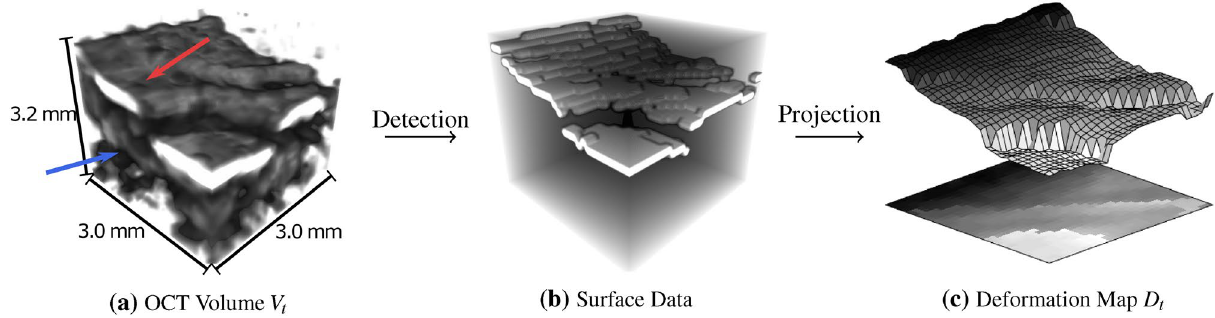
Figure 2. Data Representation: Visualization of the two data representations considered during our learning tasks. (a) The volumetric OCT scan V t contains the surface data (red arrow) and the depth information (blue arrow). (b) We detect the sample surface data in the OCT volume. (c) We project the surface data onto our 2D deformation map D t . During training, the influence of depth information is analyzed by comparing volumetric data (left) and surface projection data